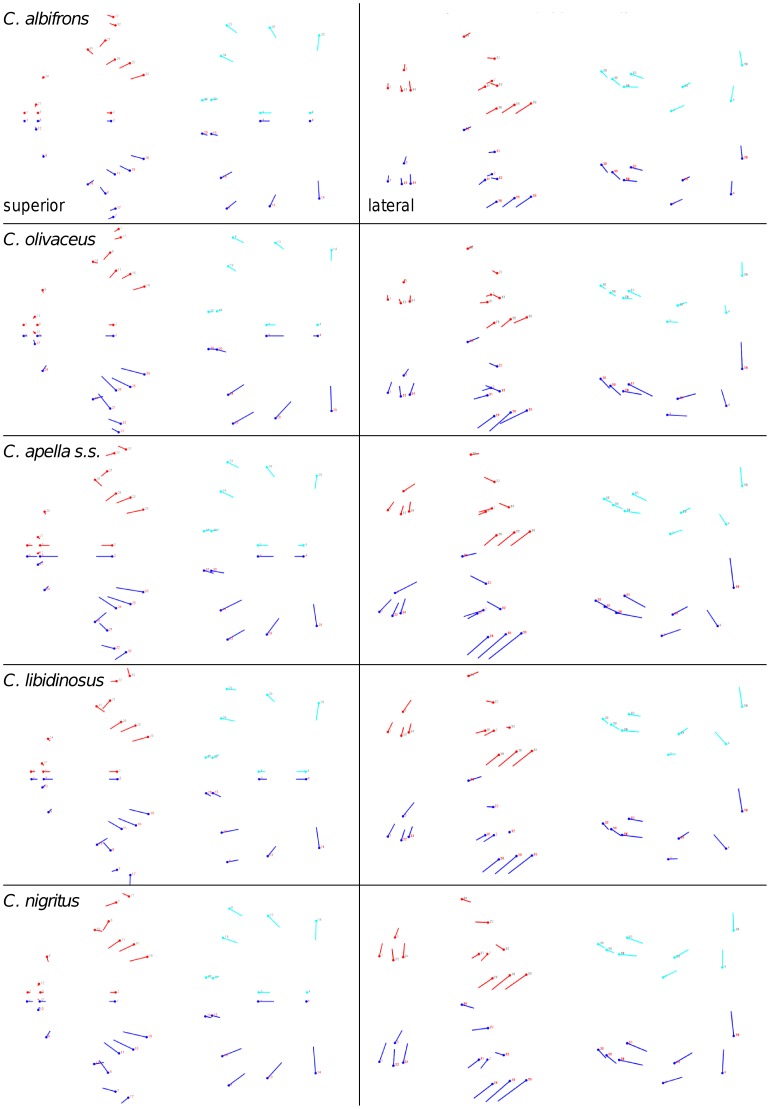
Shape change contained in the allometric face-cranial base PLS1 and the allometric PC1.Legend: oral-zygomatic PLS1 blocks colored in red and turquoise; PC1: landmark configuration colored in dark blue.